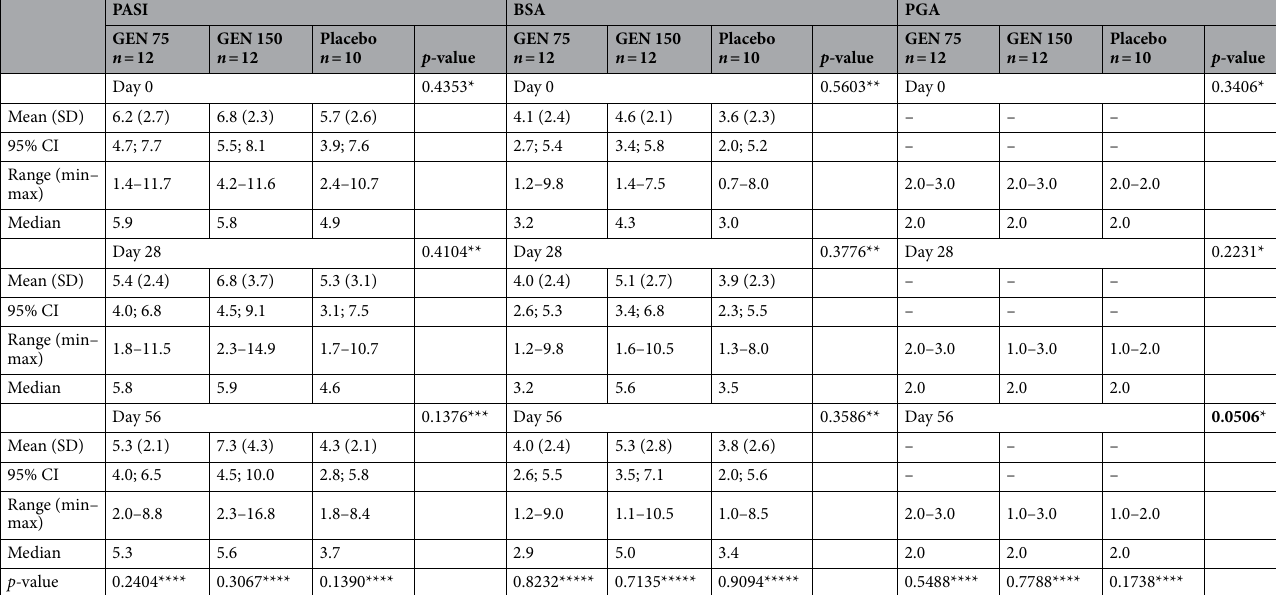
Table 1. Changes in Psoriasis Area and Severity Index (PASI), Body Surface Area (BSA), and Physician’s Global Assessment (PGA) score from visit 1 (day 0) to visit 3 (day 56) according to treatment groups